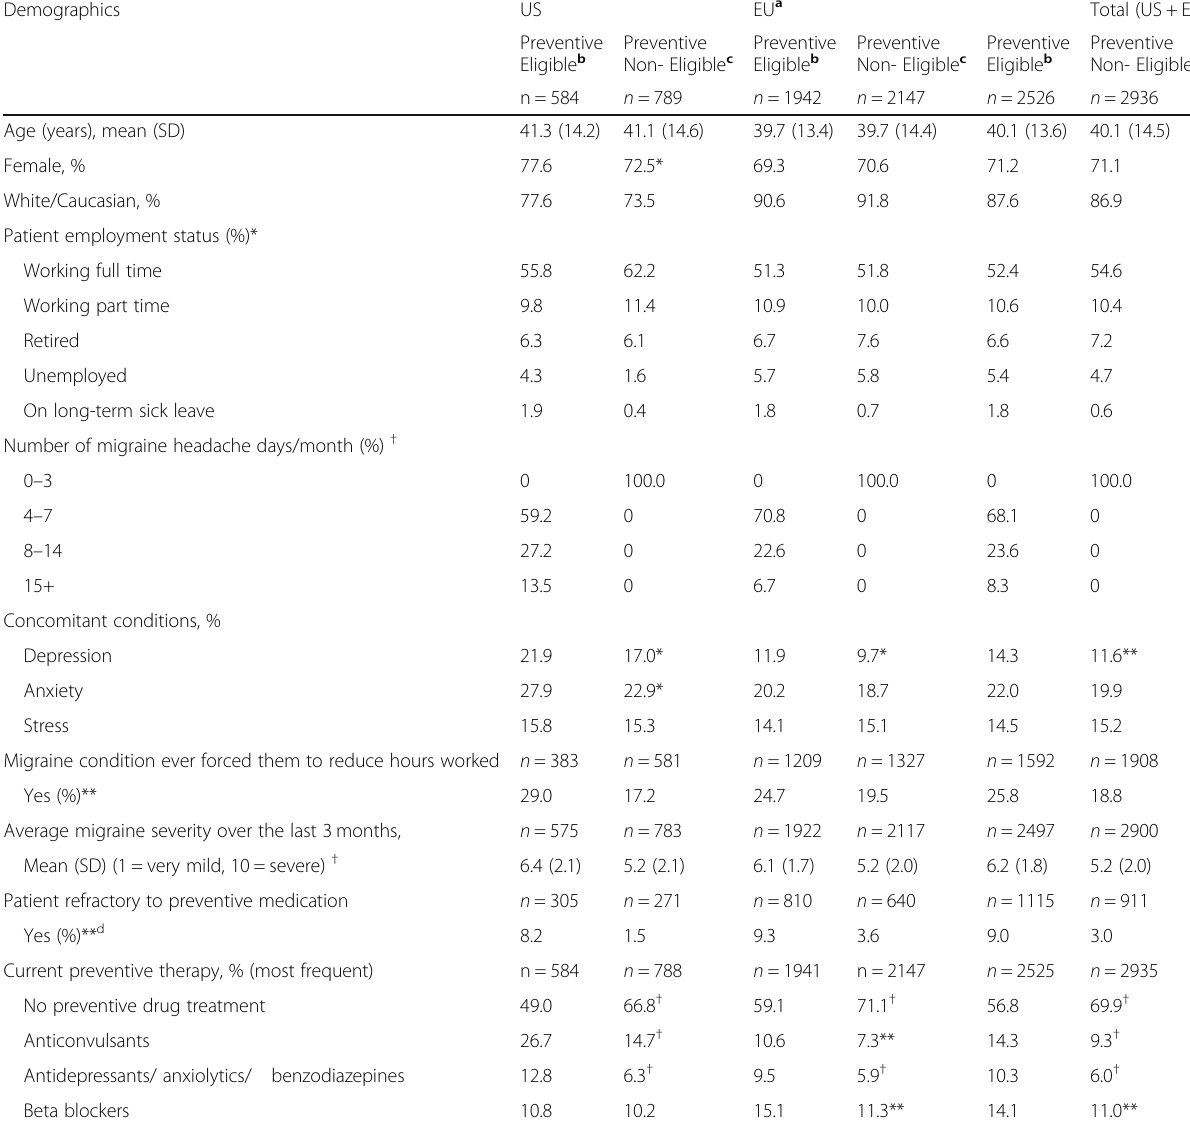
Table 1 Baseline demographics and migraine disease characteristics by preventive treatment eligibility status Demographics US EU